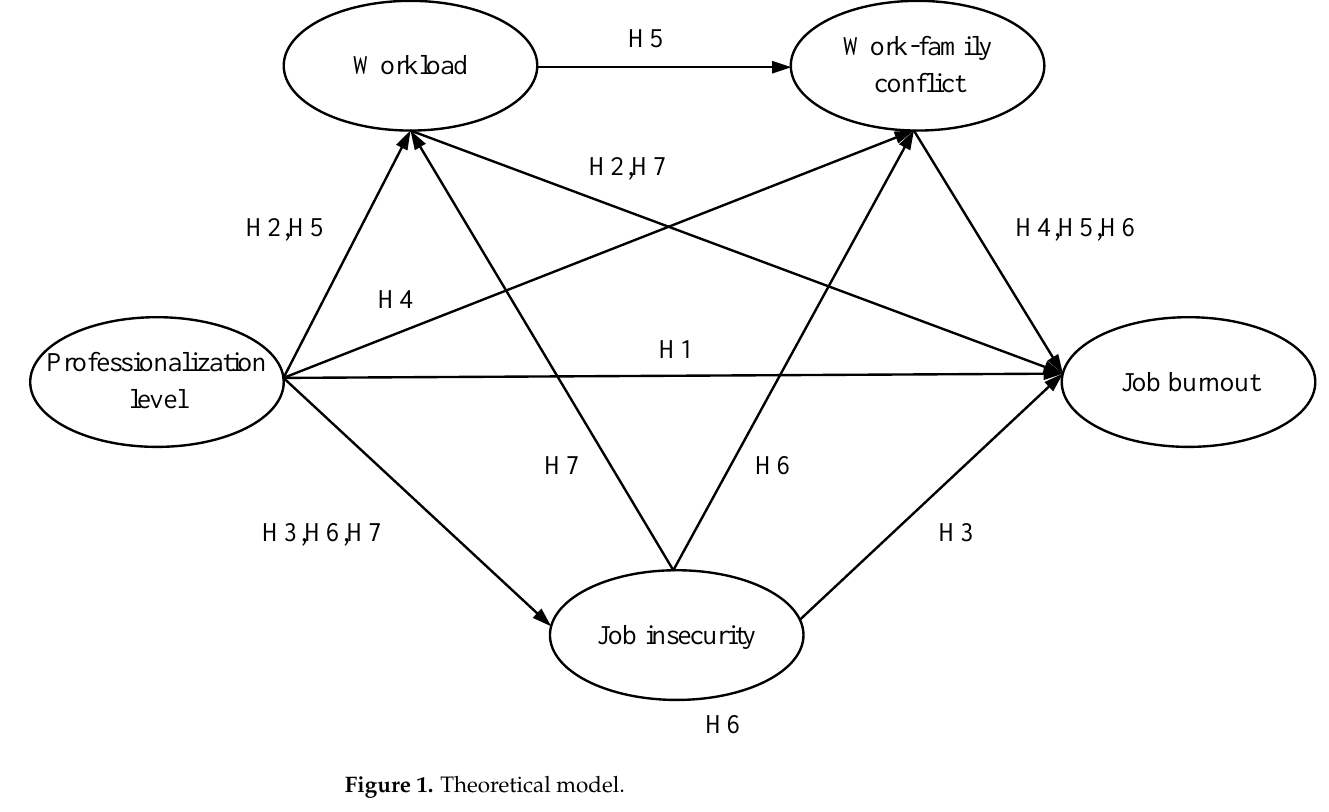
Figure 1. Theoretical